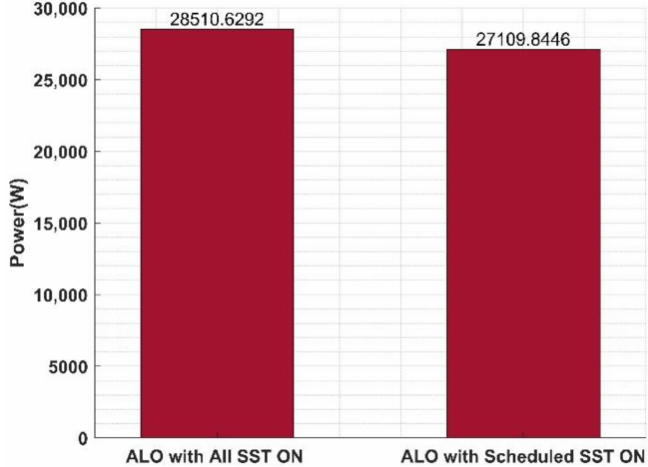
Figure 9. Comparison of ALO for scheduled and unscheduled SST scheme.